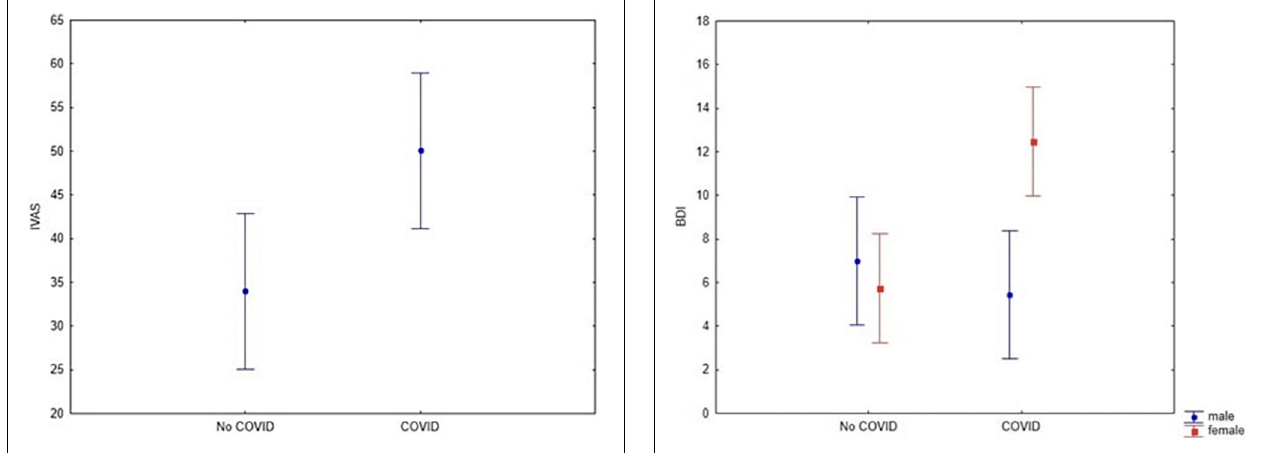
FDR-corrected = 0.0003) and the control group ( r = 0.41; p = 0.006, FDR-corrected = 0.009), respectively. Another significant correlation concerned the BDI-II and IES-R scores within women ( r = 0.51; p = 0.0001, FDR-corrected = 0.0003) and men ( r = 0.48; p = 0.003, FDR-corrected = 0.006), respectively. IVAS scores, BDI-II, and IES-R. No significant associations between BDI-II and IVAS ( r = − 0.05; p = 0.66, FDR- corrected = 0.66), and IES-R and IVAS ( r = 0.08; p = 0.47, FDR-